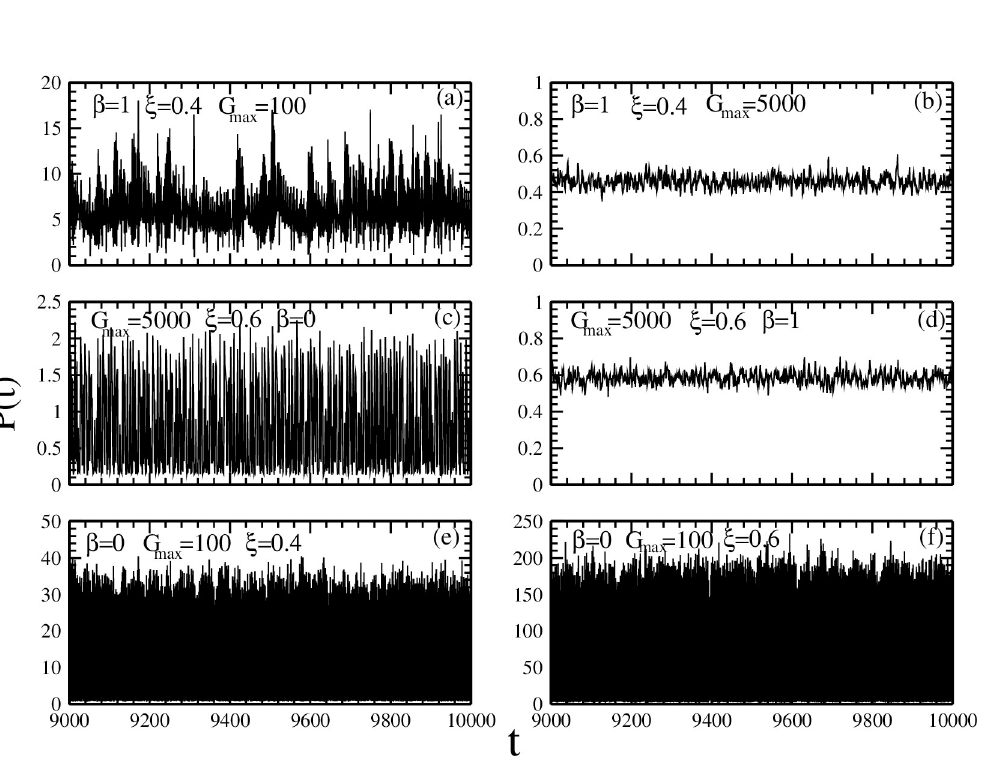
Fig 3. The dynamic stock prices P for different combinations of market impact β , maximal risk tolerance G max of = 100; (b) β = 1, reference point strategies, ratio ξ of individuals with reference point strategies. (a) β = 1, ξ = 0.4 and G max ξ = 0.4 and G max = 5000; (c) G max = 5000, ξ = 0.6 and β = 0; (d) G max = 5000, ξ = 0.6 and β = 1; (e) β = 0, G max = 100 and ξ = 0.4; (f) β = 0, G max = 100 and ξ = 0.6. Other parameters are: the population size N = 5001, the memory size m = 3 and m 0 = 10, the updating threshold of history-dependent strategies S = 0, the maximum drift of history-dependent strategies ε = 0.1, the th liquidity l ¼ N , the constant a ¼ 10 , minimum and maximum shares holding k min = -1, k max = 1. The initial conditions are: 10 N an individual’s risk tolerance G i is uniformly distributed within the range of G i 2 [0, G max ], an individual’s initial reference point p ref is uniformly distributed within the range of p ref 2 ½ � Pe (cid:0) a G i ; � Pe a G i � , initial history-dependent strategy g is distributed i i uniformly within the range of g 2 [0, 1], starting price P ( t = 0) is randomly chosen within the range of P 2 [0, 20], each individual’s initial number of shares k = 0, each individual’s initial wealth W i ( t = 0) = 0, each individual’s initial cash C i ( t = 0) =